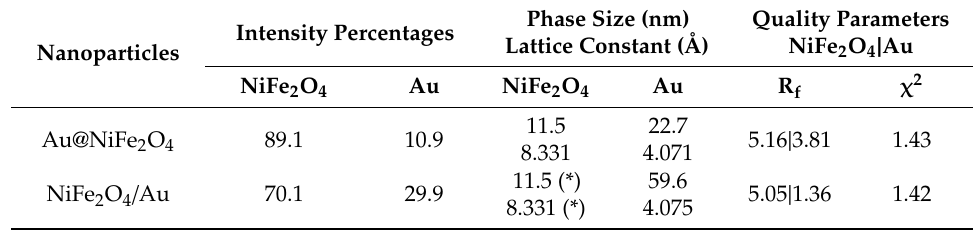
Figure 6. X-ray diffraction pattern of ( A ) nickel ferrite nanoparticles decorated with gold nanoparticles, and ( B ) core/shell nickel ferrite/gold nanoparticles. Gray lines: experimental patterns; black lines: fitted patterns. Background: short-dashed lines. Miller indices: black—nickel ferrite; red—gold. Rietveld analysis was performed using FullProf software suite (version 5.8, J. Rodríguez-Carvajal, Lab. Léon Brillouin, Gif sur Yvette, France) [34], with a background defined by linear interpolation between a set of points at constant scattering angles and refinable intensities. The calculated parameters and phase sizes are presented in Table 1. Table 1. X-ray diffraction Rietveld refinement calculated parameters R f and χ 2 , phase sizes, and